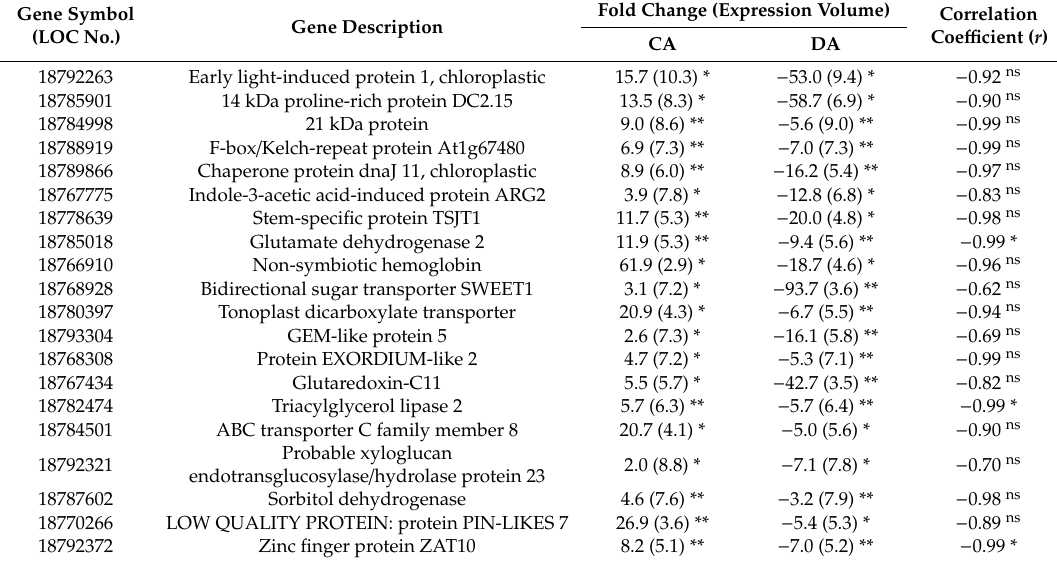
Table 3. Top 20 common DEGs up-regulated during cold acclimation (CA), from early to late CA, and down-regulated during deacclimation (DA), from late CA to late DA, in the ‘Soomee’ peach tree